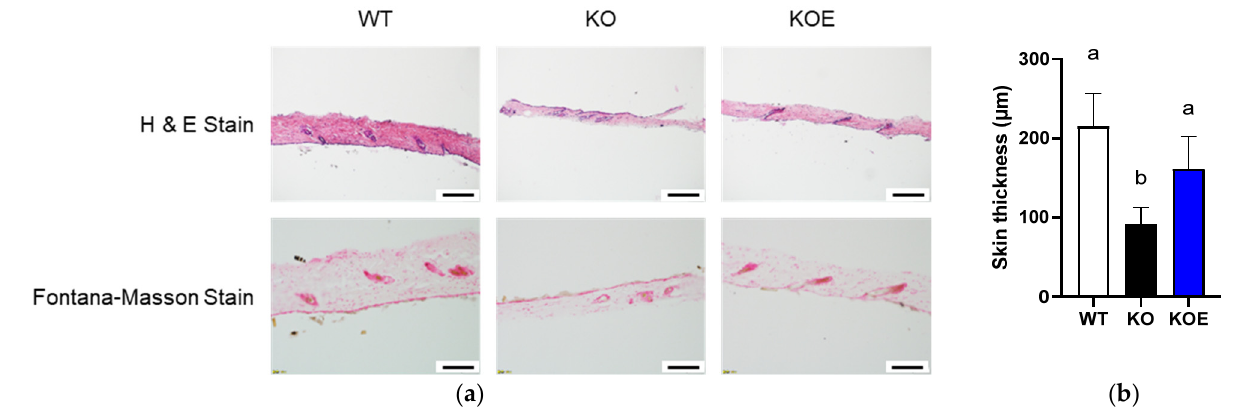
Figure 3. Effects of 8% pESM supplementation on skin morphology in IL-10 KO mice. ( a ) Results of H&E stain (upper side) and Fontana-Masson Stain (lower side); ( b ) Skin thickness based on H&E stain. Data are means ± SD, n = 5, 7 and 6 for WT, KO and KOE groups, respectively. The different lowercase alphabets indicate significant differences between the tested-group ( p < 0.05). WT: Wild type, KO: IL-10 knockout mice, KOE: KO mice supplemented with 8% pESM.